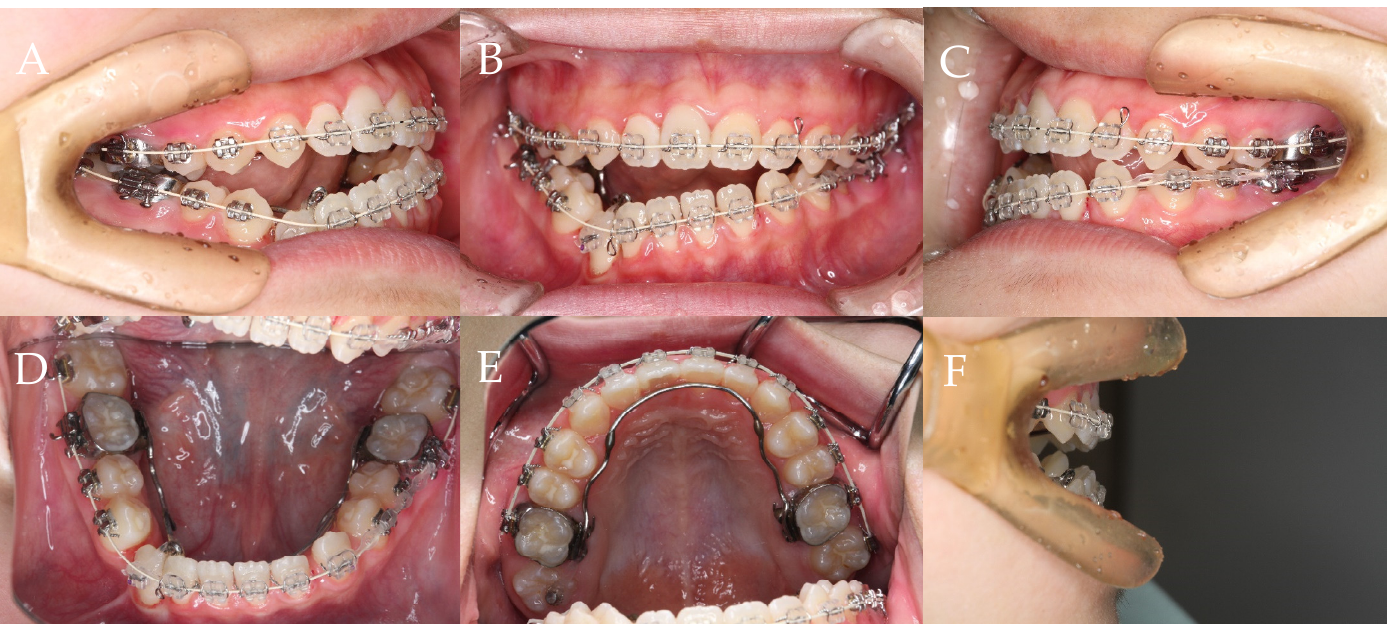
Figure 5. Leveling after surgical luxation of ankylosed teeth. ( A ) Right side view; ( B ) front view; ( C ) left side view; ( D ) upper occlusal view; ( E ) lower occlusal view; ( F ) incisal view.